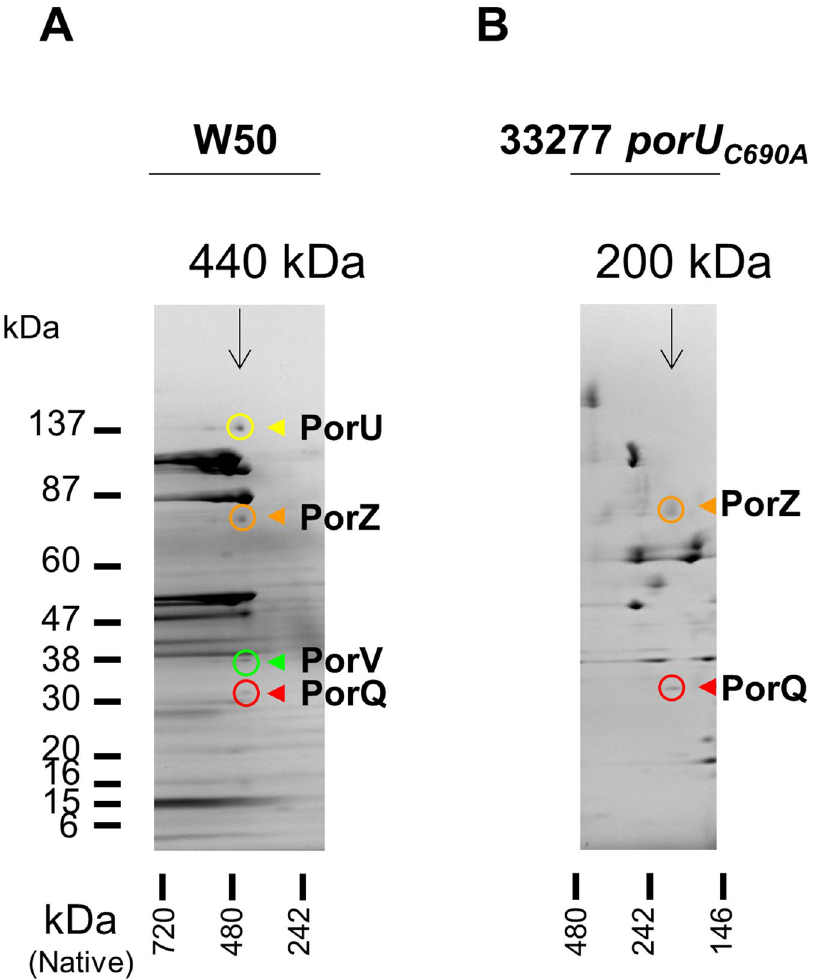
Figure 1. 2D BN-PAGE analysis of OMV lysates reveals components of the sortase (PorU) attachment complex. Coomassie stained 2D BN-PAGE analyses for ( A ) large scale glycerol gradient fraction F17 of crude W50 OMV lysate, ( B ) glycerol gradient fraction F6 of W50 porU C690A OMV lysate. Positions of PorU, PorZ, PorV and PorQ identified by MS are indicated by coloured circles and arrowheads. Native size of complexes are shown above. See Supplementary Fig. S1 and Supplementary Table S1 for spot numbers and MS